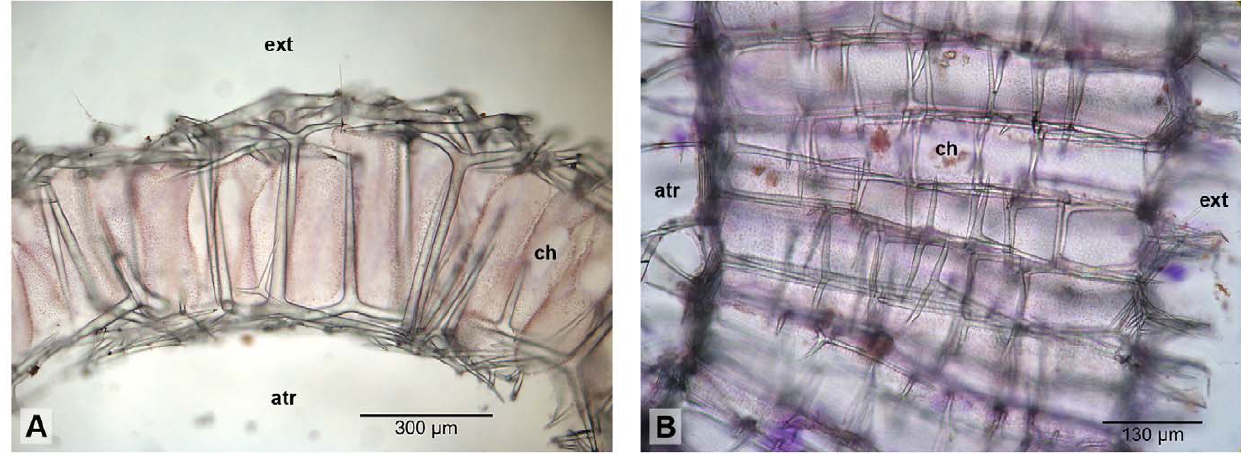
Figure 2. Organization of choanoskeleton. A: inarticulated ( Sycettusa aff. hastifera ); B: articulated ( Grantessa sp. GW974).